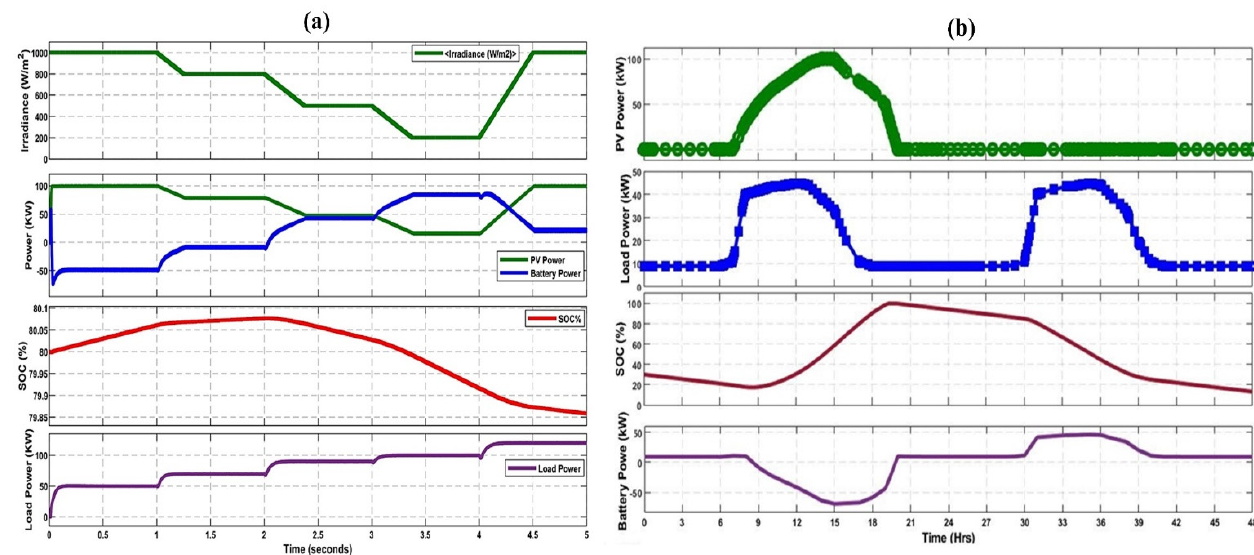
Figure 17. ( a ) Variation of PV power, SOC and Battery power with changing of load power computed for ( a ) variable irradiance and ( b ) 24 h absence of irradiance with load profile of an academic institute.